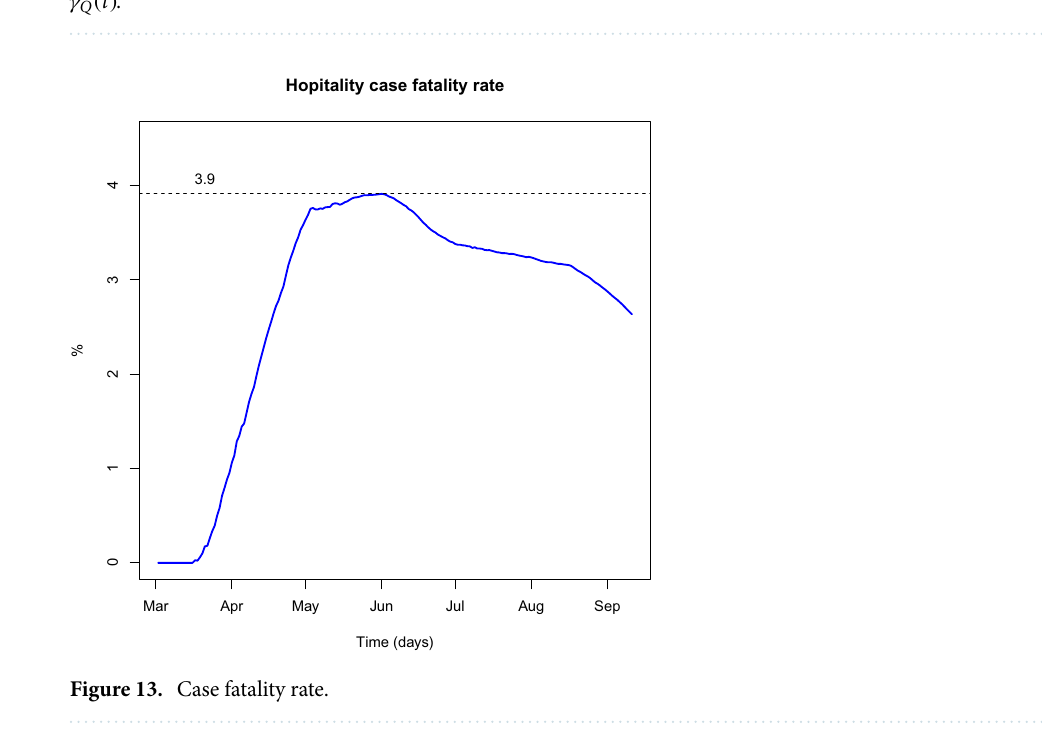
Figure 12. Recovery rate. ( a ) Asymptotic recovery rate for quarantined individuals’ distribution, γ 0 Q . ( b ) Recovery rate for hospitalised individuals’ distribution, γ H . ( c ) Recovery rate course for quarantined individuals, γ Q ( t ) .